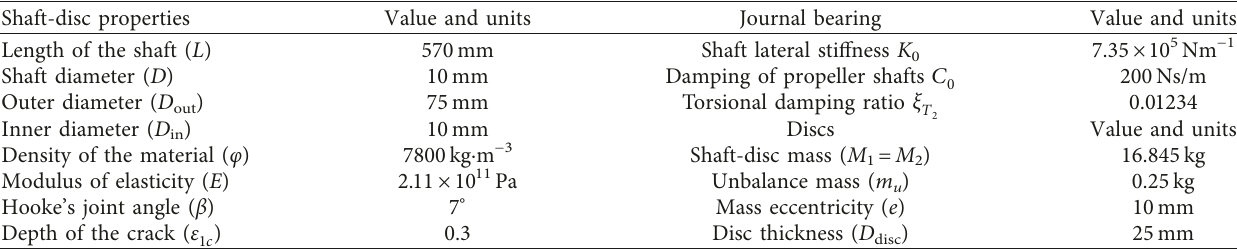
Table 1: Cardan shaft system parameters.